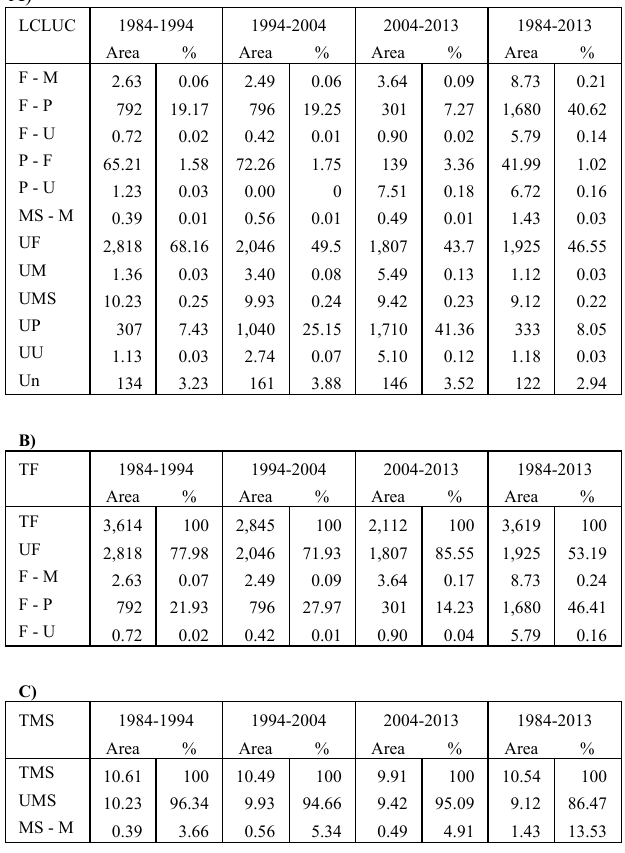
Table 2. A summary of land cover and land use change trajectories from object based approach. A) Quantification of LCLUC between 1984-1994, 1994-2004, 2004-2013 and